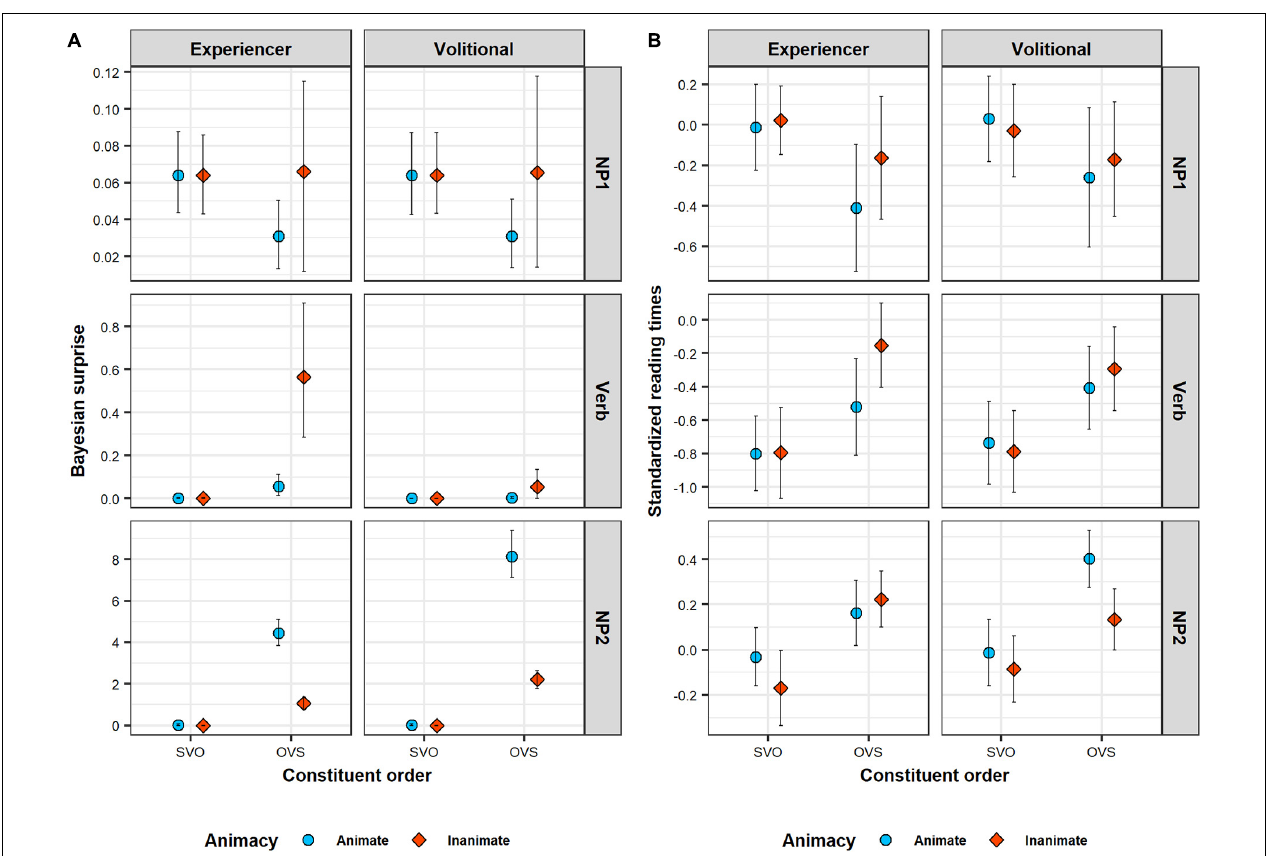
FIGURE 4 | Predicted Bayesian surprise ( Panel A ) compared to length-corrected reading times ( Panel B ) across sentence regions of the critical sentences (rows). Bayesian surprise is derived from the rational model described in Section “A Rational Model of Incremental Argument Interpretation.” Length-corrected reading times are grand averages within each design condition. Note that the range of the y-axis differs between sentence regions. Error bars in (Panel A) illustrate 89% across-item average HPDIs of predicted Bayesian surprise, calculated on the basis of the posterior predictions of the underlying GLMMs. Error bars in (Panel B) are 89% confidence intervals, calculated on the basis of